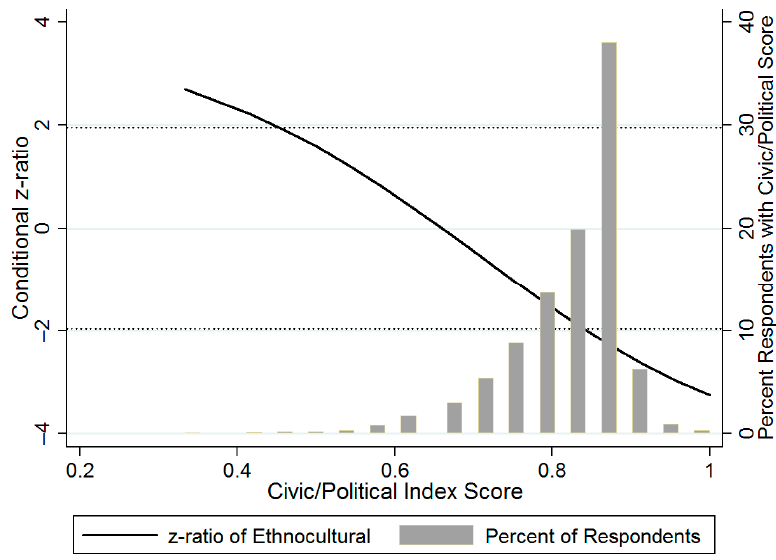
Figure 2. Conditional z-ratio for the ethnocultural dimension score.